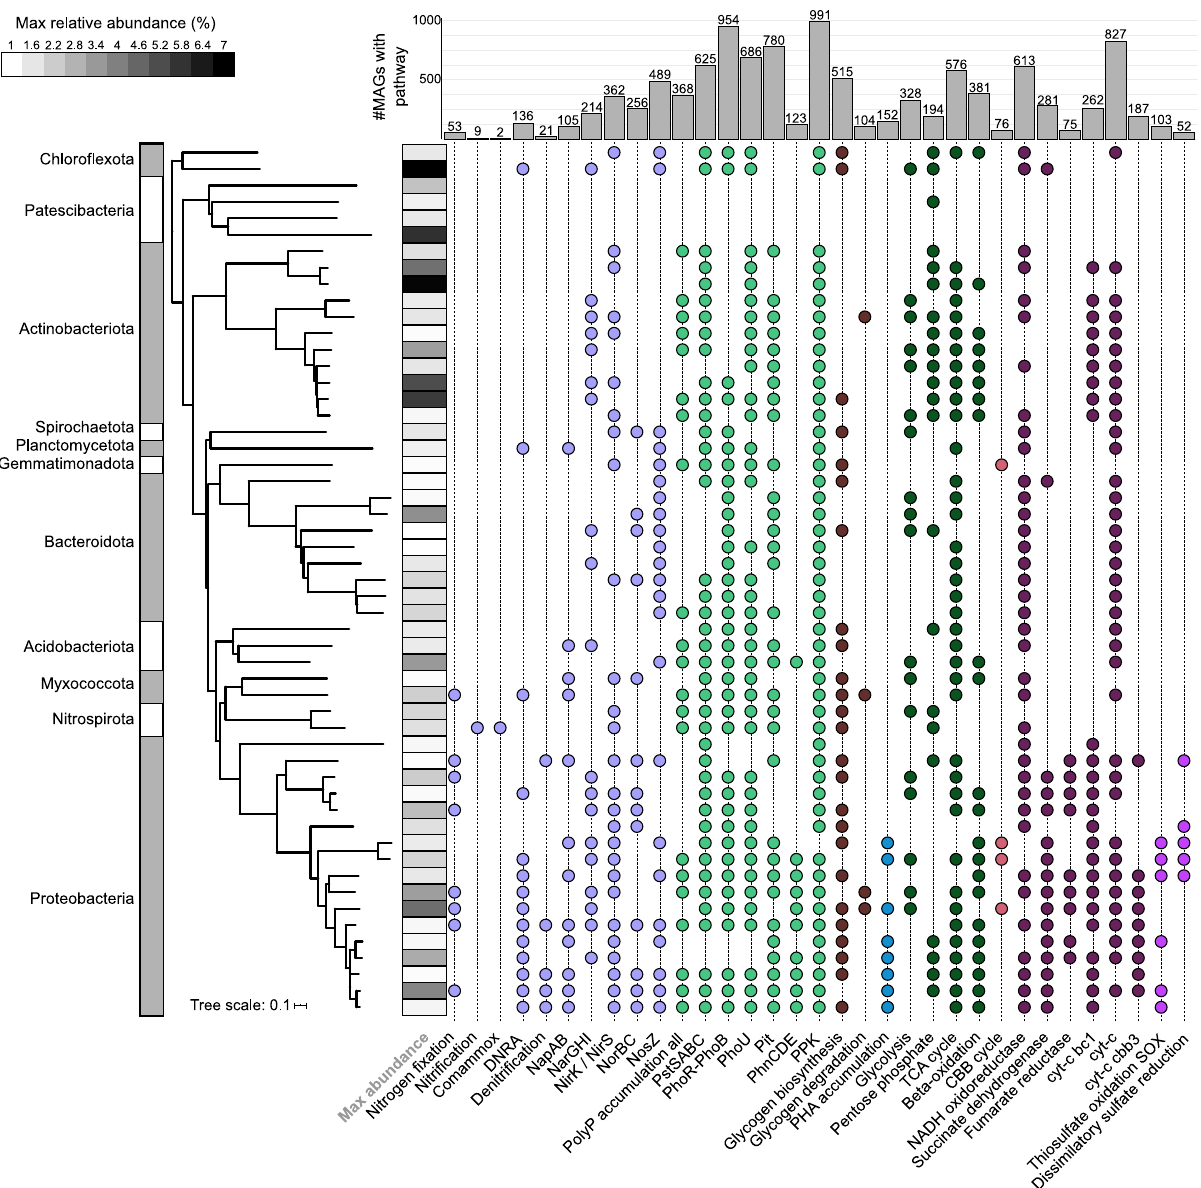
Fig. 4 Functional pro fi les of the top 53 bacterial species representatives with relative abundances >1% in at least 1 sample metagenome used in this study. Pathways are considered present if 100% of the genes in the KEGG module, or custom module (Supplementary Data 12), are encoded. Heatmap strip indicates the maximum relative abundance of the population in the metagenomes. Colors are to aid visual interpretation, e.g., purple for nitrogen- related metabolisms and green for phosphate-related metabolisms. Bar chart indicates the number of MAGs encoding the pathway of interest. Supplementary Fig. 6 shows the full taxonomic string for the